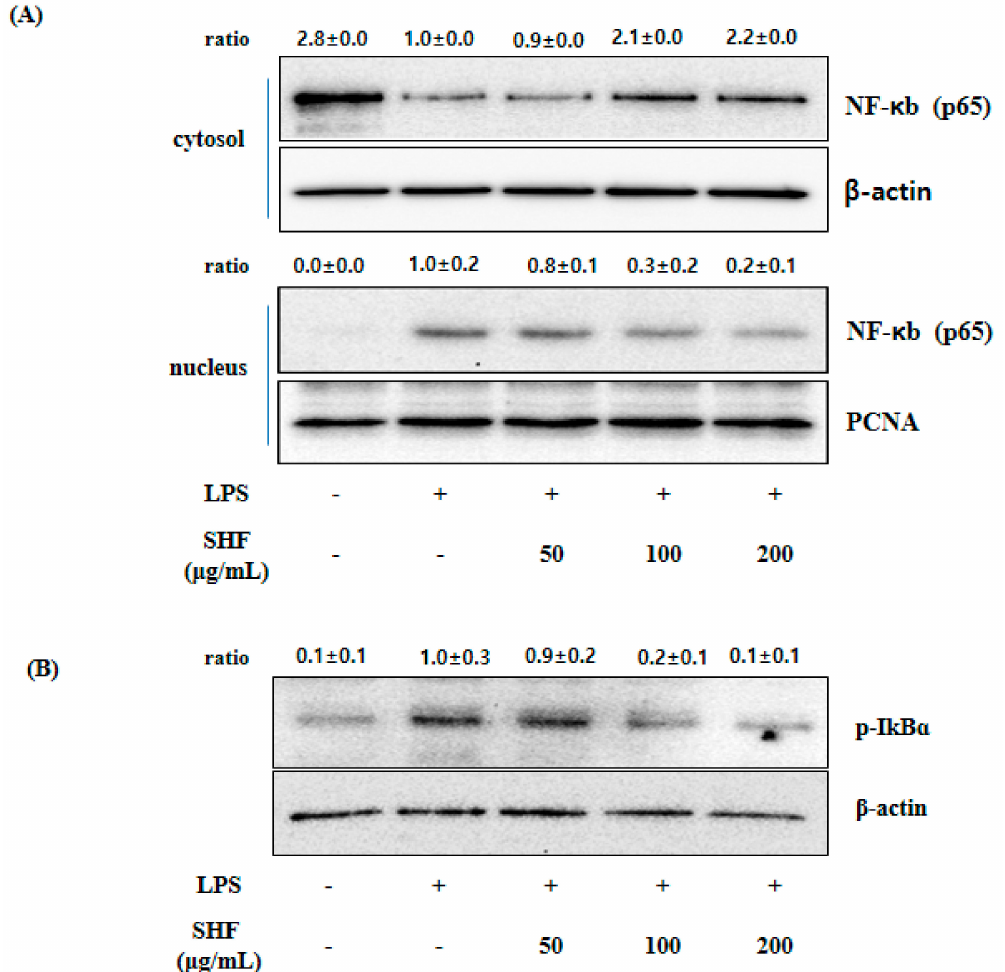
Figure 7. Effect of the Stauntonia hexaphylla fruit (SHF) extract on nuclear factor (NF)- κ B translocation in RAW 264.7 cells. Cells were treated with 50, 100 and 200 µ g/mL of the SHF extract and later treated with LPS (1 µ g/mL) for 18 h. After treatment, nuclear and cytosolic extracts were prepared, and equal amounts of proteins were separated by Western blot analyses. ( A ) NF- κ B protein expression was determined using an antibody specific for p65; ( B ) Samples were treated as described for Figure 4, and phosphorylation of inhibitor of κ B (I κ B) α was analyzed by Western